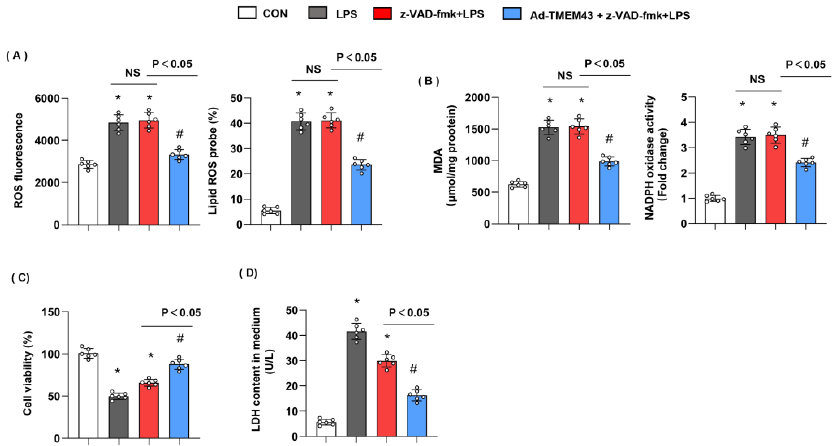
Figure 11. Apoptosis inhibitor could not blur the protective effects of TMEM43. ( A ) ROS level and lipid ROS level in H9c2 cells in each group ( n = 6). ( B ) MDA and NADPH oxidase activity in each group ( n = 6). ( C , D ) Cell viability and LDH level in H9c2 cells ( n = 6). * p < 0.05 vs. CON group. # p < 0.05 vs. LPS group.